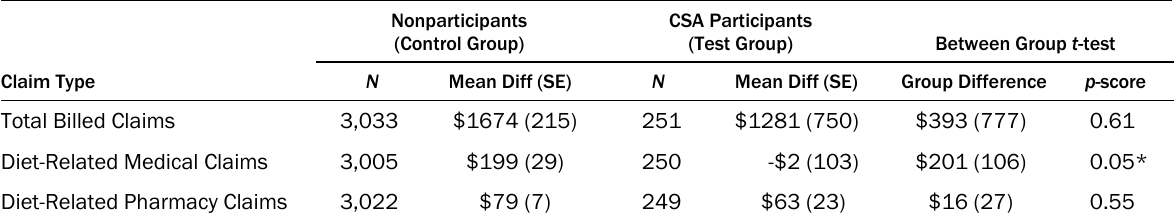
Table 5. Annual Differences in Billed Medical Claims for CSA Participants and Non-Participants Nonparticipants (Control